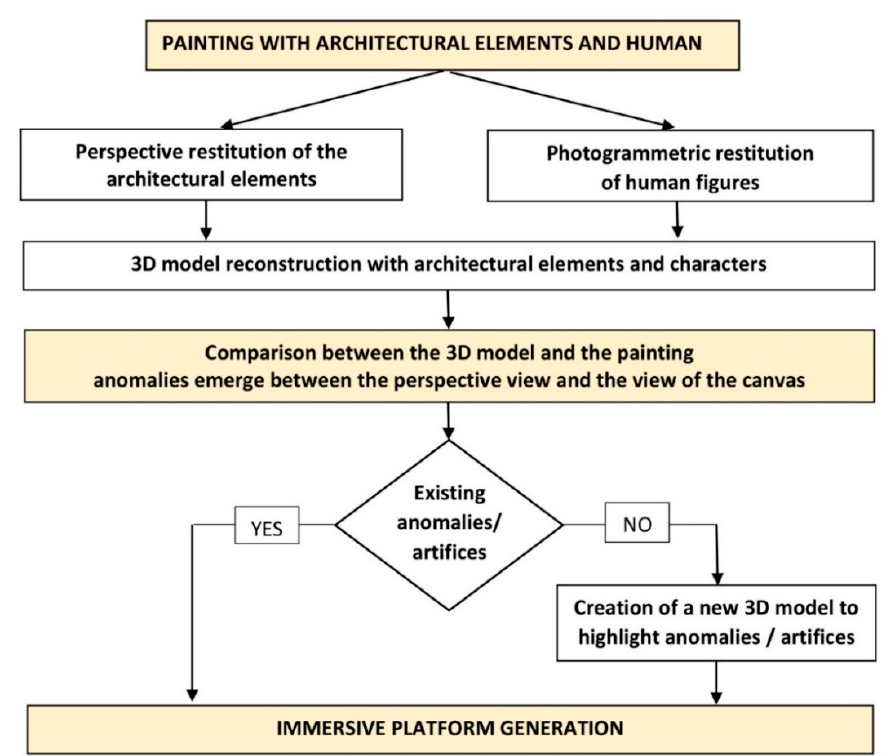
Figure 3. Flow chart illustrating the methodology